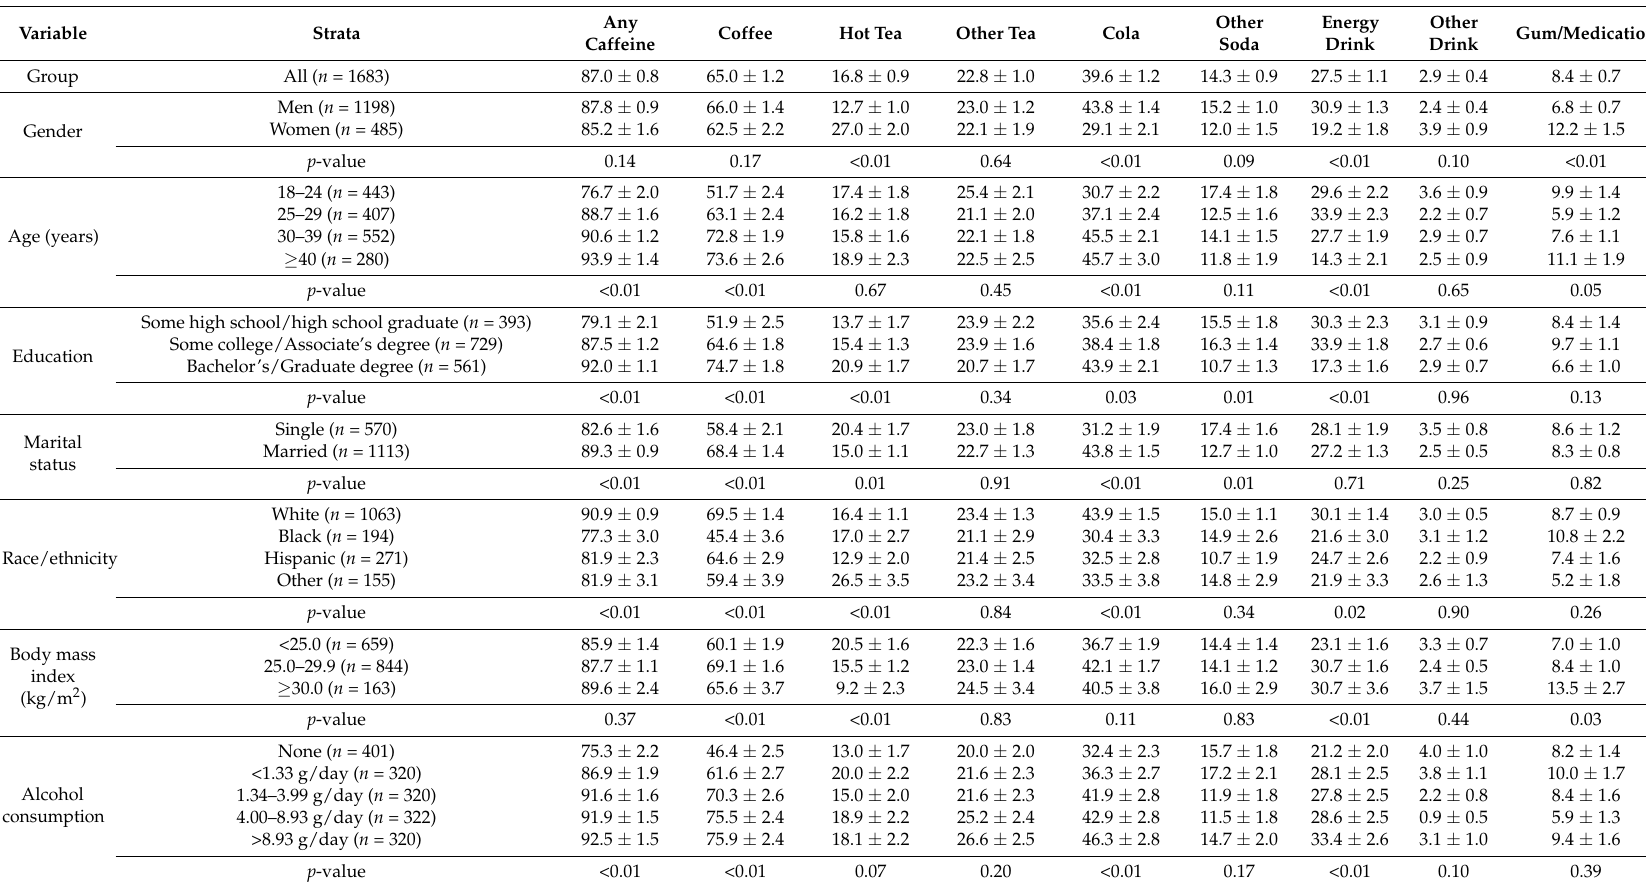
Table 2. Prevalence (% ± SE) of reported use of caffeine ( ≥ 1 time/week) among Navy and Marine Corps personnel by demographic, lifestyle, and military characteristics. ( p -values are from chi-square